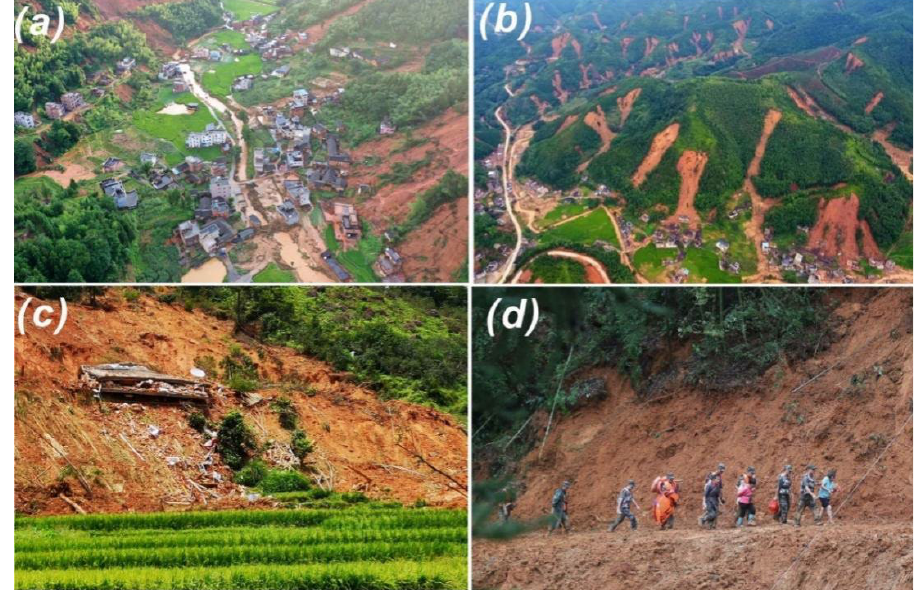
Figure 4. ( a ) Aerial photograph of Mibei village after the rainfall event, houses are damaged by rainfall-induced landslides; ( b ) group-occurring shallow landslides; ( c ) the landslide damaged the hillside residences, and the floors on the second floor crashed on the first floor; ( d ) road damage caused by landslides (Picture source: http://www.gdlctv.com/Pc/index/new_detalis.html?id=3320, accessed on 25 June 2022) .